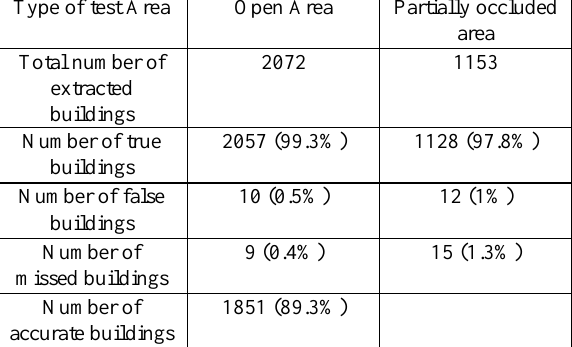
Table 1 Test Results of Automatic Extraction of